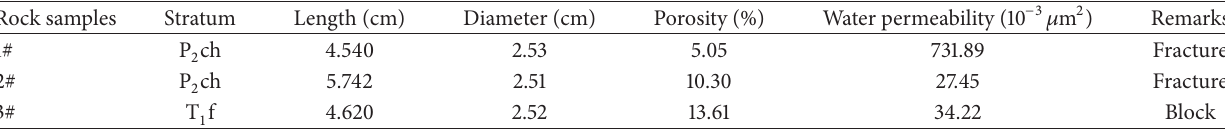
Table 1: Physical properties of the rock samples.